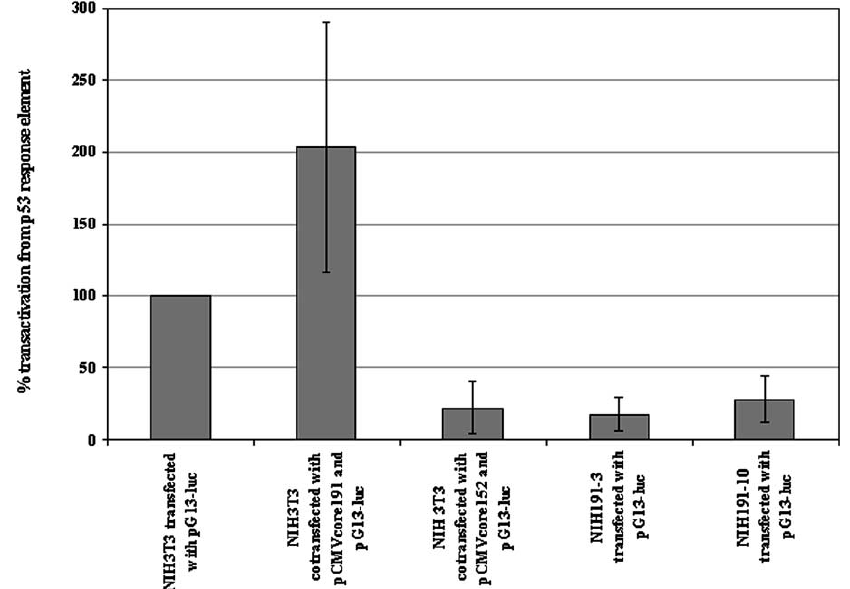
Fig. 8. Transcriptional activation of p53 in the HCV core-expressing clones NIH191-3, and NIH191-10 as compared to the parental NIH 3T3 taken for 100%. To estimate the influence of HCV core on the endogenous p53, NIH191-3 and NIH191-10 were transfected with luciferase-expressing reporter plasmid pG13-luc, and parental NIH 3T3 were co-transfected with pG13-luc and pCMVcore191, or